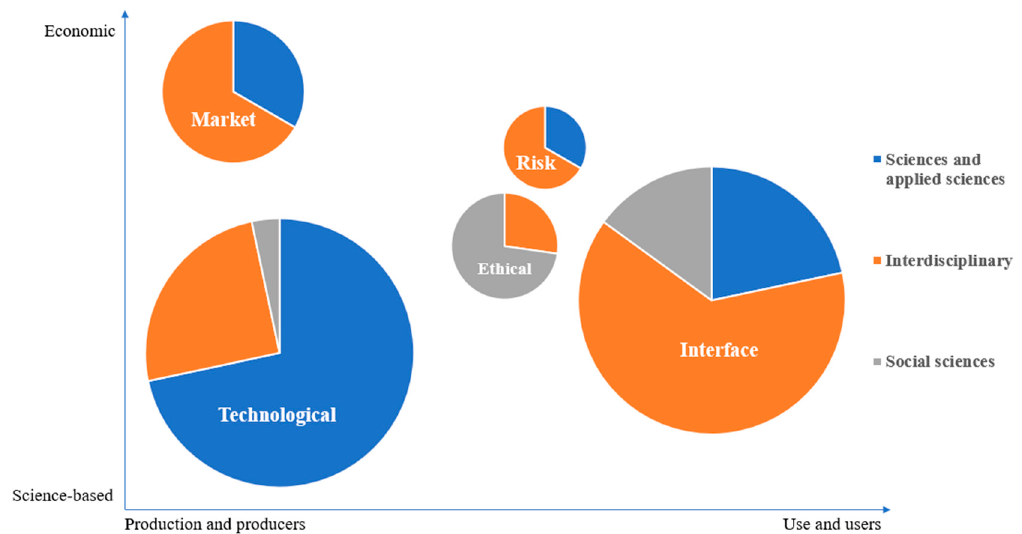
Figure 3. Disciplinary background and logics behind framing climate information services (CIS).